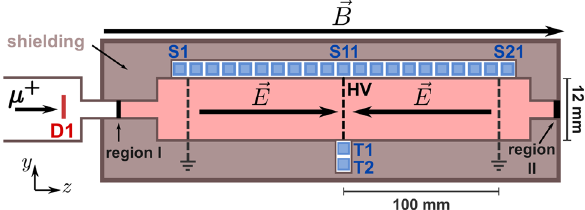
Fig. 2 Sketch of the He gas target used to measure the longitudinal compression (not to scale). The muon beam passes through an entrance detector D1, target window (region I) and enters the He gas (indicated in pink). Some of the muons are stopped in the gas and subjected to the electric field, pointing towards the center of the target. A large fraction of the muons pass through the target and stop in region II. Several scintillators (S1, ... , S21, T1, T2) detect the positrons from muons